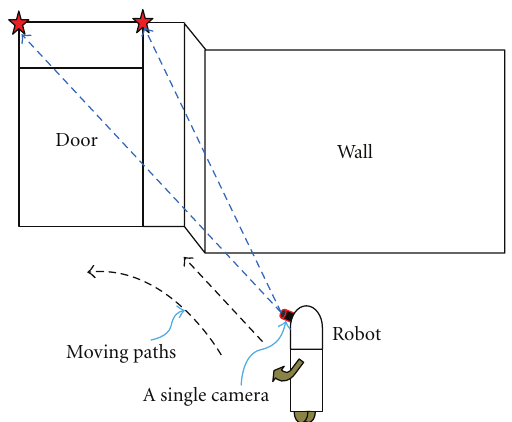
Figure 5: The experiments are designed to localize the natural landmarks as targets with varied linear and angular velocity patterns in di ff erent moving paths including the straight and curved paths.